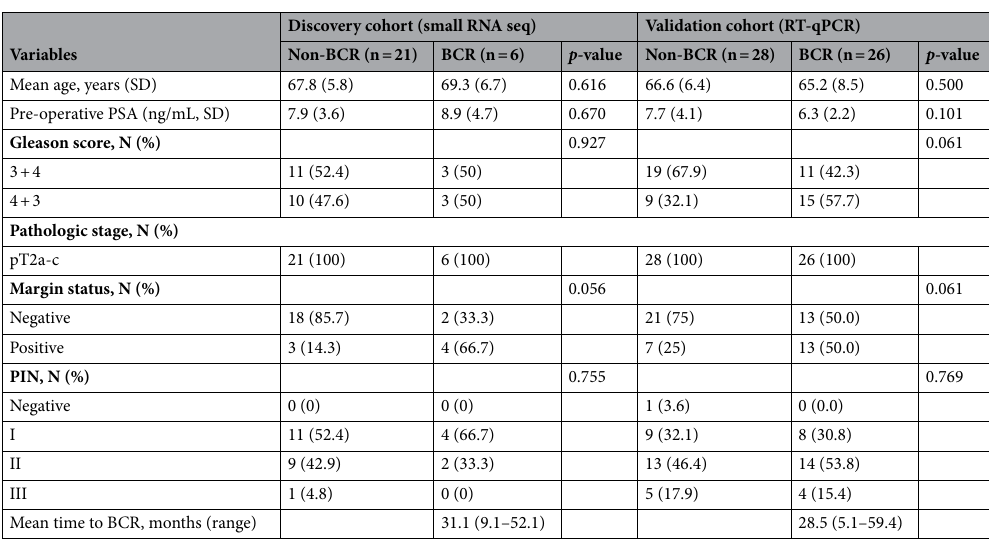
Table 1. Clinical characteristics of patients in the discovery and validation